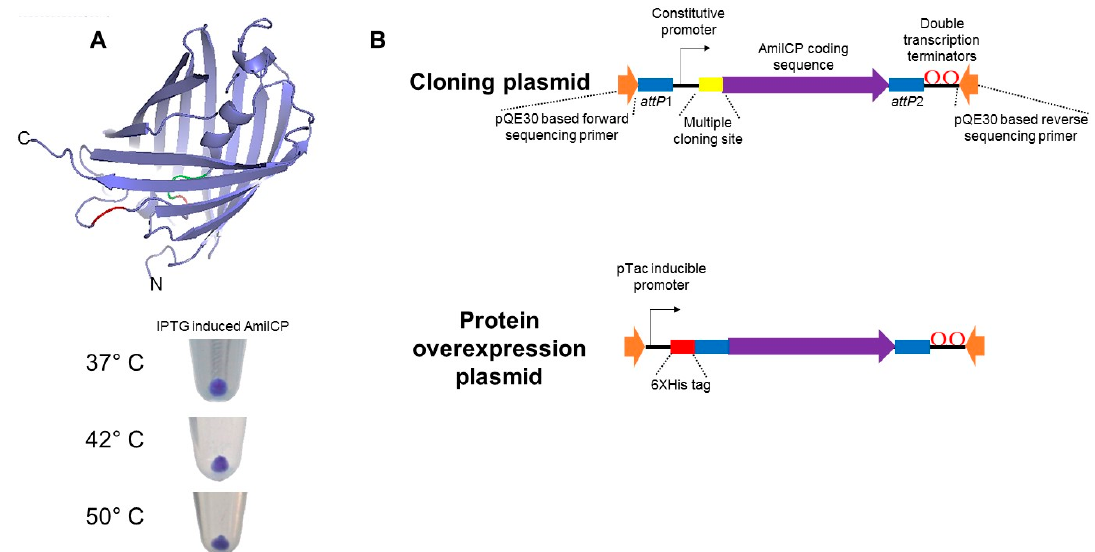
Figure 1. AmilCP predicted structure and plasmid cassette designs. Panel ( A ), predicted structure of AmilCP, the known residues related to GFP fluorescence (Ser65-Tyr70-Pro71) are shown in green, which correspond to residues. The chromoprotein signature of this family of proteins is Gln61, Tyr62 and Gly63, indicated in red [25]. Bellow the predicted structure, cell pellets of E. coli expressing cells from an IPTG inducible plasmid (pQE30) incubated at different temperatures for 1 h, showing that the protein retains its color even in stressing temperatures. Panel ( B ), Cassettes designed for cloning and protein expression. All cassettes can be replaced using standard BP Clonase™ reactions.